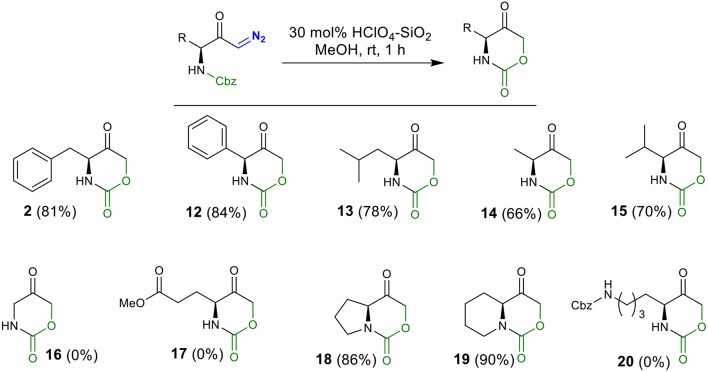
Synthesis of oxazinanones from diazo carbonyls via silica-supported HClO4 catalysis.